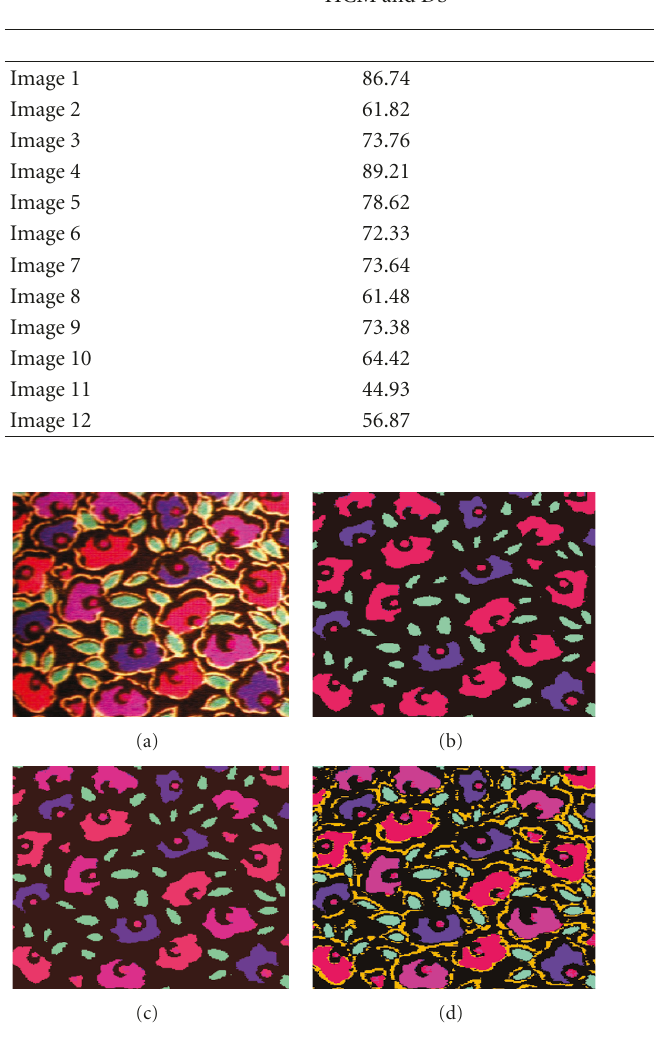
Figure 4: Comparison of the proposed segmentation method with other existing methods on a synthetic image (6 classes). (a) Original image (256 × 256 × 3): colour synthetic image with RGB description, (b) segmentation based on HCM and DS, (c) segmentation based on FCM and DS, and (d) segmentation based on homogeneity and DS.